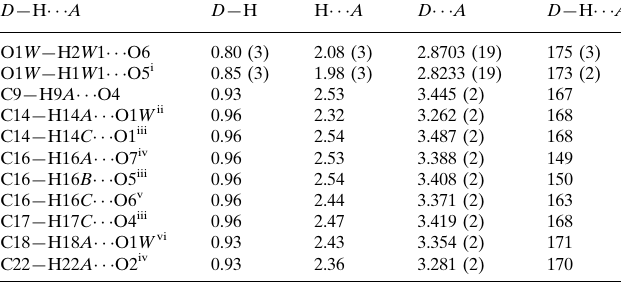
Data collection Bruker APEXII CCD area-detector diffractometer Absorption correction: multi-scan ( SADABS ; Bruker, 2005) T min = 0.927, T max = 0.989 Refinement R [ F 2 > 2 (cid:2) ( F 2 )] = 0.045 wR ( F 2 ) = 0.124 S = 1.05 5219 reflections 320 parameters